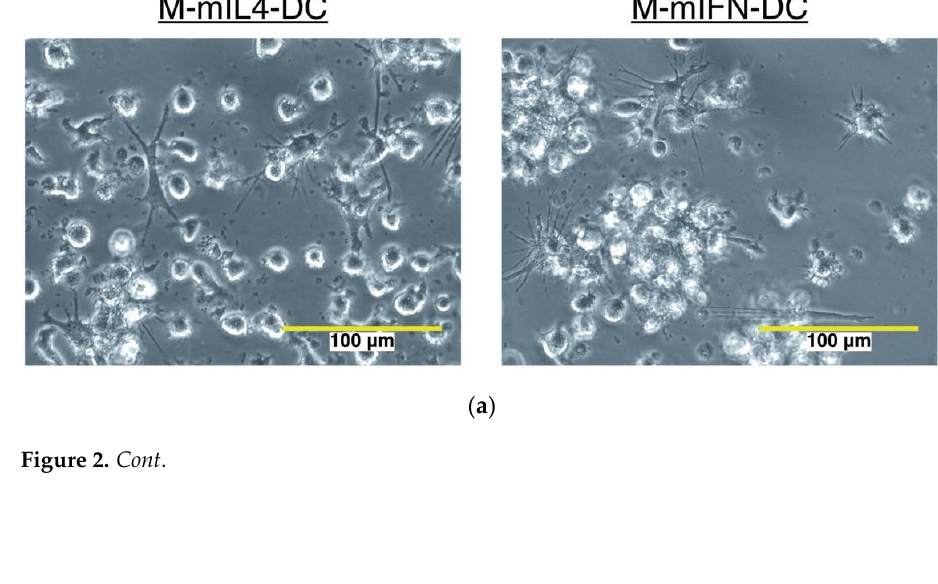
Figure 1. Protocol of MUTZ-3-derived Dendritic cell (DC) and dexosome induction. M-imIL-4-, M-mIL4-, M-imIFN-, and M-mIFN-DCs were generated as described in